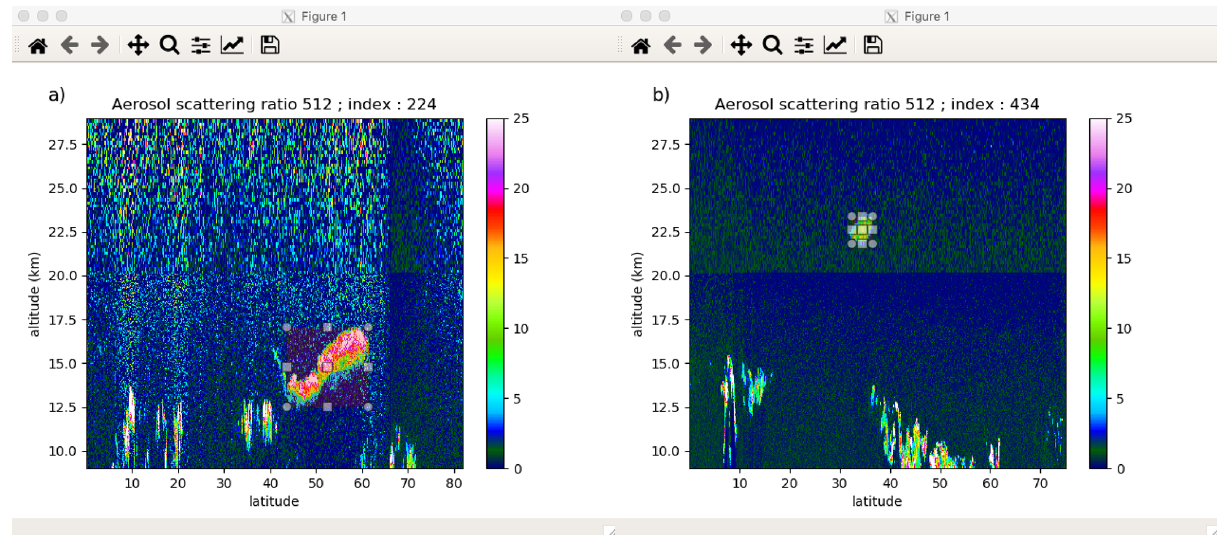
Figure A1. CALIOP sections with the superimposed box showing how the interactive tracking is performed: (a) daytime orbit over bubble O on 19 August, and (b) night-time orbit over bubble A on 24